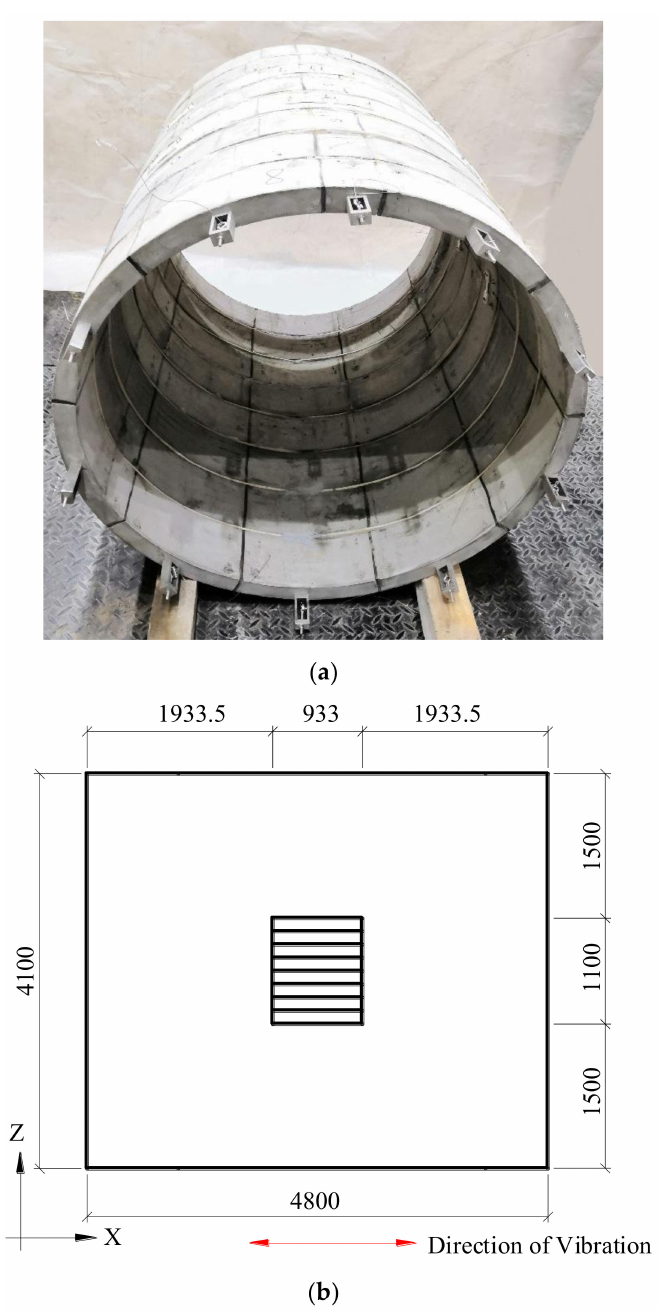
Figure 8. Soil–tunnel model (unit: mm). ( a ) Model tunnel. ( b ) Plane